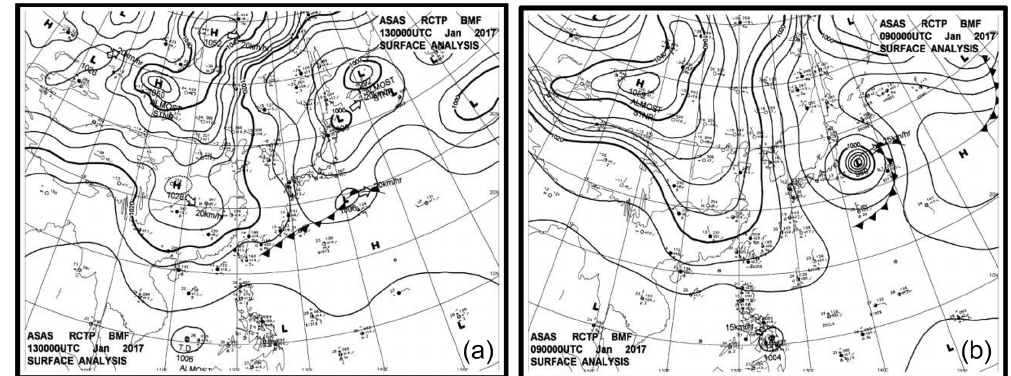
Figure 6. The surface weather map at 08:00LT (a) on 13 January and (b) 9 January 2017, respectively.